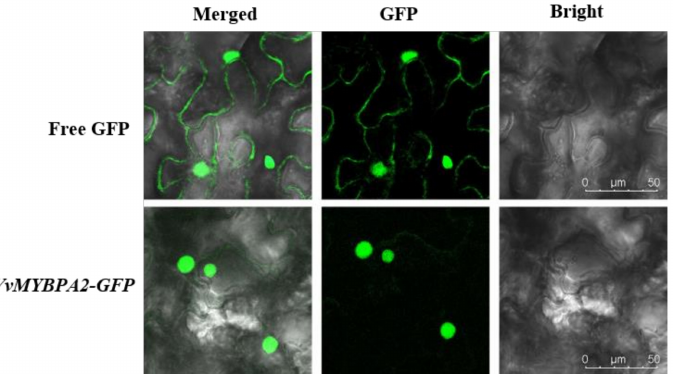
Figure 1. Subcellular localization of VvMYBPA2 in tobacco leaf cells. The empty GFP vector was used as a control. The images were taken in the dark field for green fluorescence ( middle ), bright light to demonstrate the morphology of the cells ( right ) and in overlay ( left